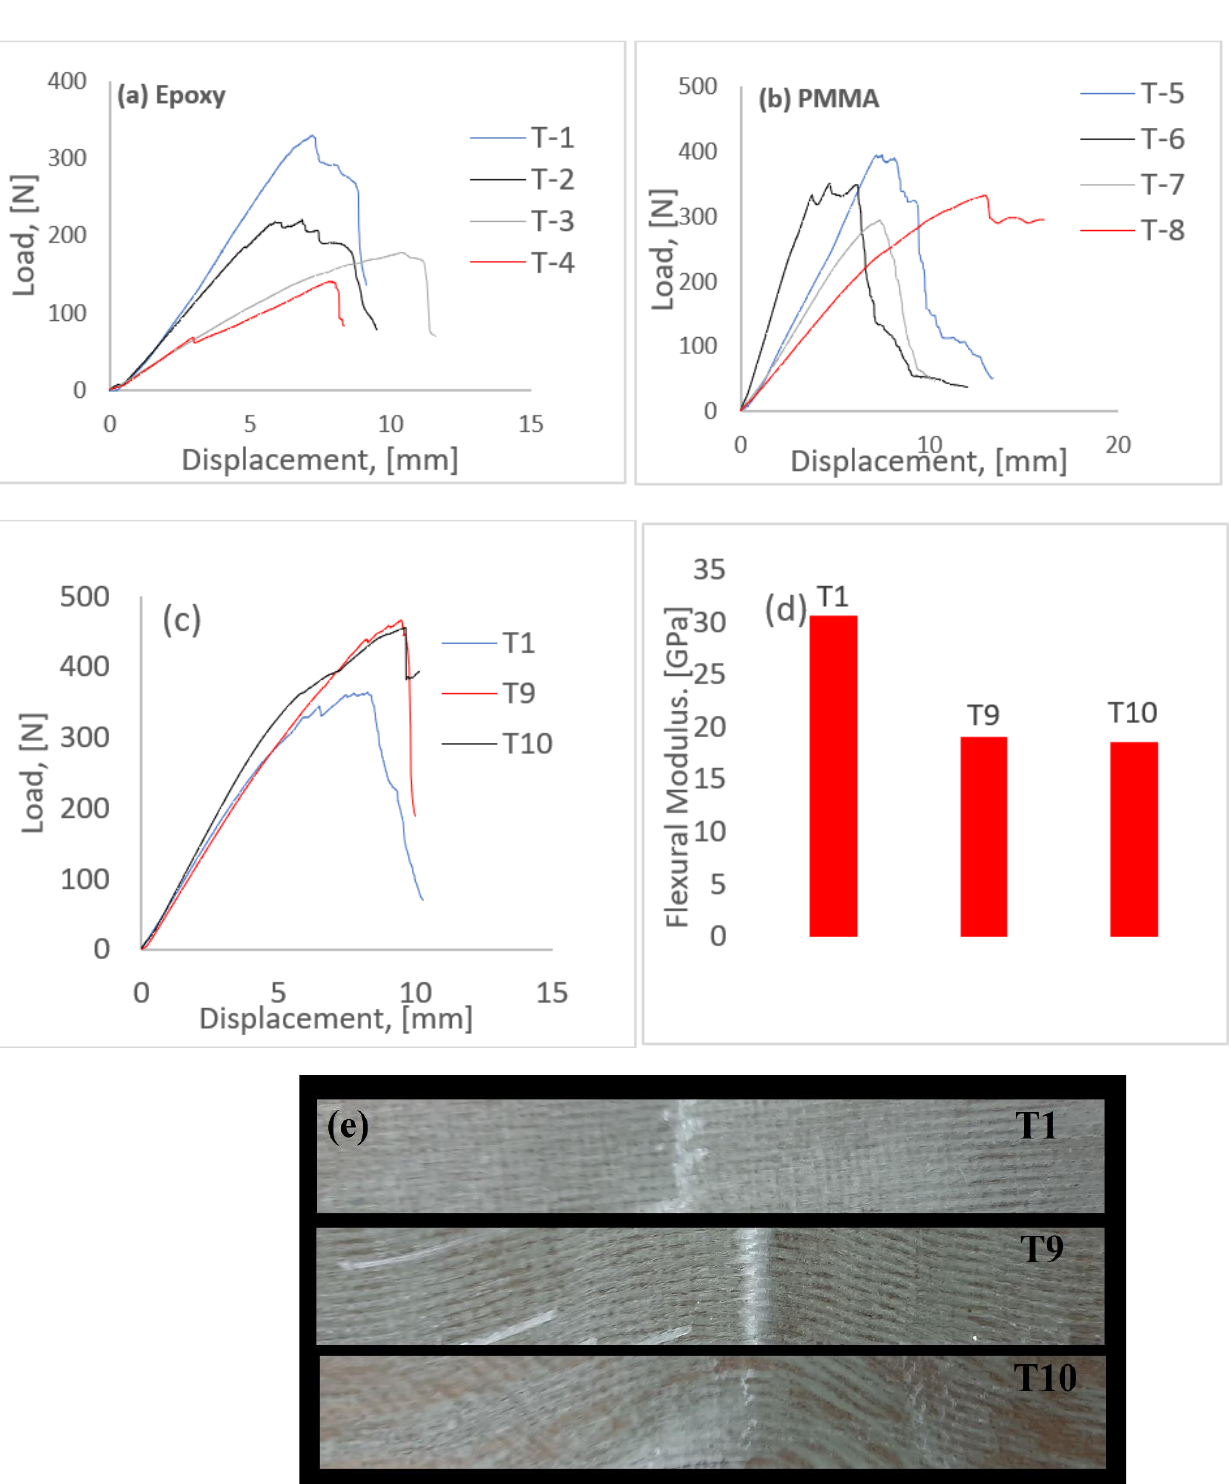
Figure 3. Load displacement curve from the flexural test. ( a ) Specimens with epoxy resin, ( b ) speci- mens with PMMA as resin, ( c ) specimens with in-plane waviness, ( d ) flexural modulus of specimens with in-plane waviness, and ( e ) specimens post-failure (in-plane waviness). The results are indications that hybrid composites can be beneficial by altering dam- age mechanisms, though compromises on strength and stiffnesses are to be expected.